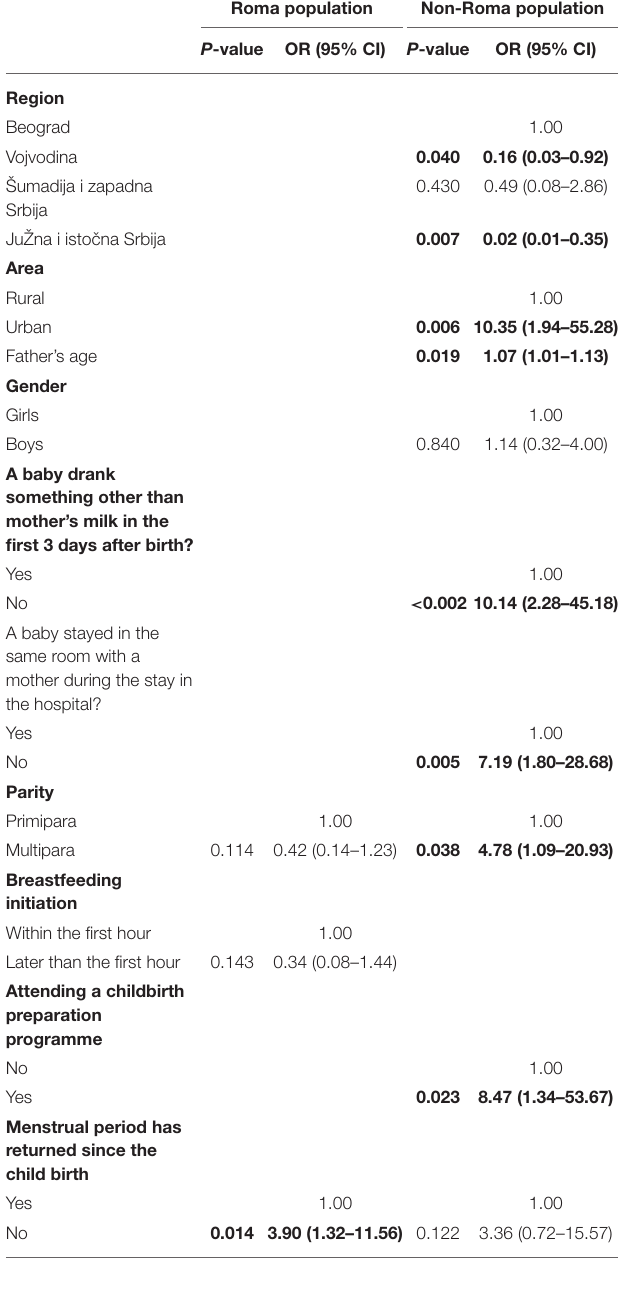
TABLE 6 | The associations between mothers’ characteristics and the practice of exclusive breastfeeding—Univariate logistic regression. Roma population